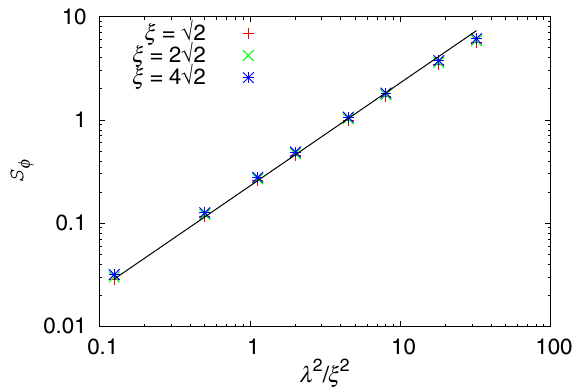
FIG. 3. Scaling of the total entropy production as a function of λ , showing that S ϕ ∝ λ 2 , as predicted analytically. Here, ffiffiffiffiffiffiffiffiffiffiffiffiffiffiffiffiffiffiffi p ξ ¼ − ð κ = 2 a is the passive interface width. Values of the 2 Þ parameters used are ð a 2 ¼ − 0 . 5 ; a 4 ¼ 0 . 5 ; κ ¼ 2 ; D ¼ 0 . 001 Þ , ð − 0 . 25 ; 0 . 25 ; 4 ; 0 . 001 Þ , and ð − 0 . 125 ; 0 . 125 ; 8 ; 0 . 001 Þ for the red, green, and blue points,